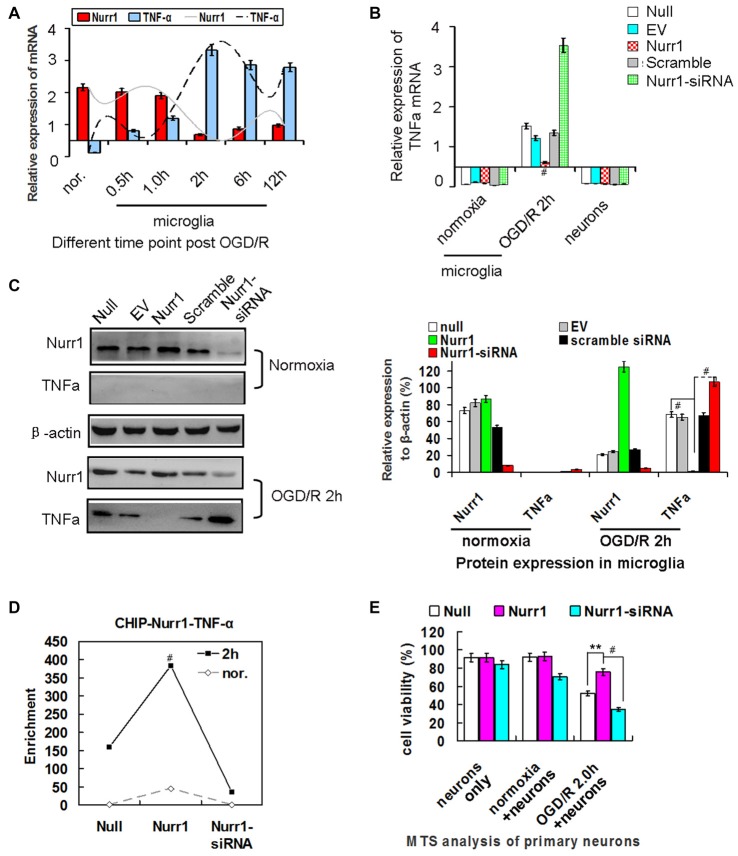
Nurr1 overexpression suppresses TNF-α expression in microglia. (A) Quantitation of Nurr1 and TNF-α mRNA in primary microglia which were subjected to OGD/R 0.5 h, 1.0 h, 2 h, 6.0 h and 12 h, respectively. TNF-α mRNA increased from the onset of OGD/R and peaked at OGD/R 2 h in microglia (p < 0.001). However, Nurr1 mRNA showed an opposite trend at different time point of OGD/R. (B) Overexpression of Nurr1 led to significant attenuation of TNF-α mRNA, otherwise Nurr1-siRNA led to sharply increase of TNF-α expression after OGD/R 2 h in microglia. However, these significant changes of TNF-α mRNA expression were not observed in microglia with normooxia culturing (microglia nor. group) or neurons only group. (C) After OGD/R 2 h in microglia, Nurr1 overexpression by pcDNA-Nurr1 transfection significantly inhibited TNF-α protein expression (p < 0.001). Oppositely, Nurr1 knockdown by siRNA interference significantly restored TNF-α protein expression (p < 0.001). (D)
ChIP assay of Nurr1 on the TNF-α promoter in response to OGD/R 2 h in microglia cells. Nurr1 overexpression by plasmid transfection increased Nurr1 occupancy at the TNF-α promoter, especially when TNF-α expression reached great amount post OGD/R 2 h. Data are displayed as fold enrichment over control IgG. (E) By MTS analysis of neurons, neurons viability co-cultured with microglia OGD/R 2 h which were transfected with Nurr1 overexpression plasmid showed significant lower ratio of cell death than the null (p < 0.01) and Nurr1-siRNA group (p < 0.001). However, no obvious changes of cell viability were observed in groups of neurons only and neurons+microglia normoxia after overexpression or knockdown Nurr1 expression. **p < 0.01, #p < 0.001.